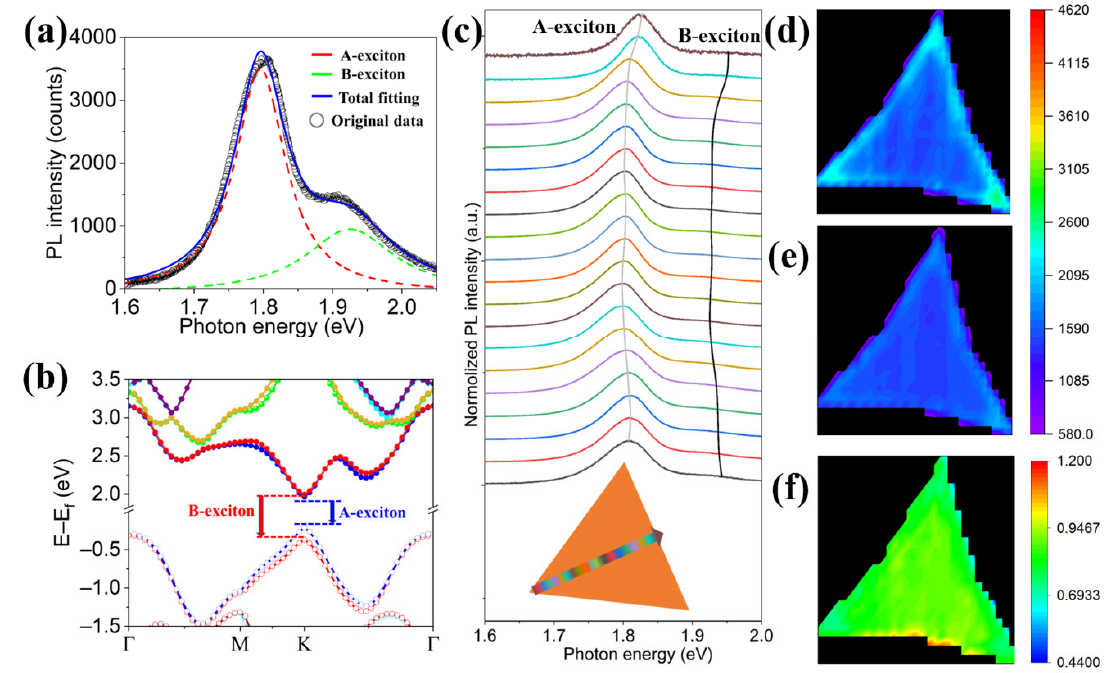
Figure 2. ( a ) A typical PL spectrum of the monolayer MoS 2 . ( b ) The SOC ‐ dependent band structure of the monolayer MoS 2 . The solid and hollow circle represent conduction and valence band, respectively. The energy levels are marked by different colors. ( c ) The PL spectra with linear scanning from the vertice to edge of the MoS 2 triangle. The inset shows the scanning path and the colors of PL spectra indicate the site position. ( d – f ) The intensity mapping profiles of ( d ) A ‐ exciton, ( e ) B ‐ exciton, and ( f ) intensity ratio of B/A.